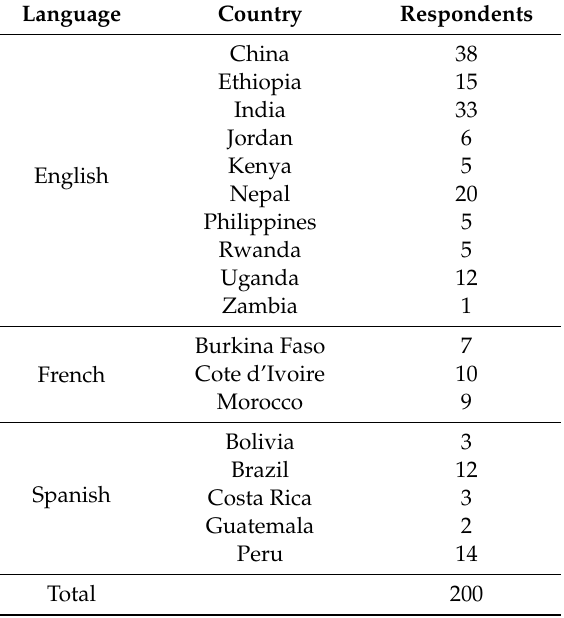
Table 1. Sample frame of the